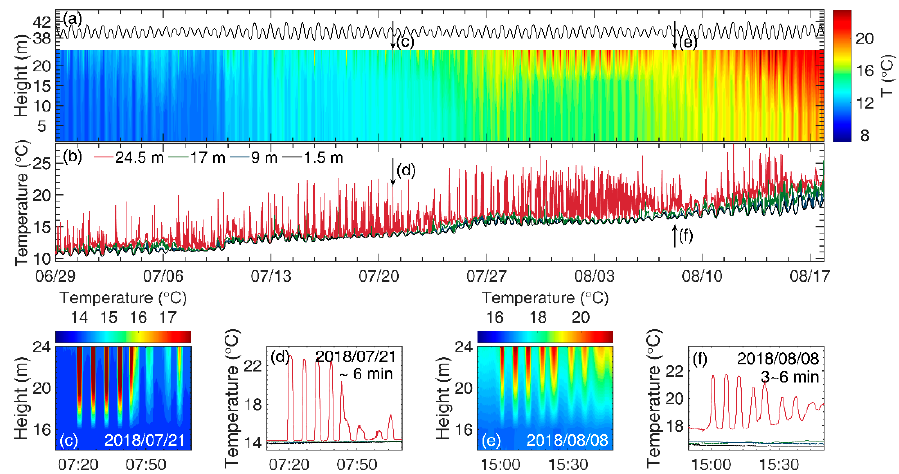
Figure 2. ( a ) Time–depth variations of observed temperature at Stn. A4. The black curve represents sea surface elevation. ( b ) Temporal variation of temperature as monitored by four temperature sensors. ( c – f ) Close views of the high–frequency variation of the temperature.